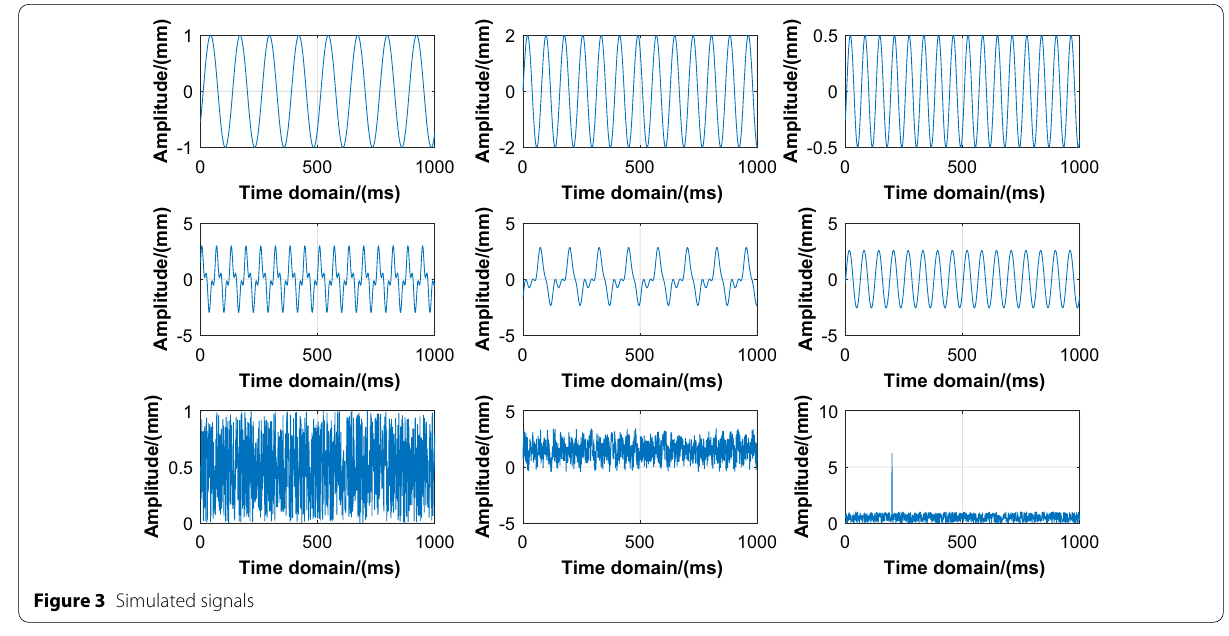
Figure 3 Simulated signals